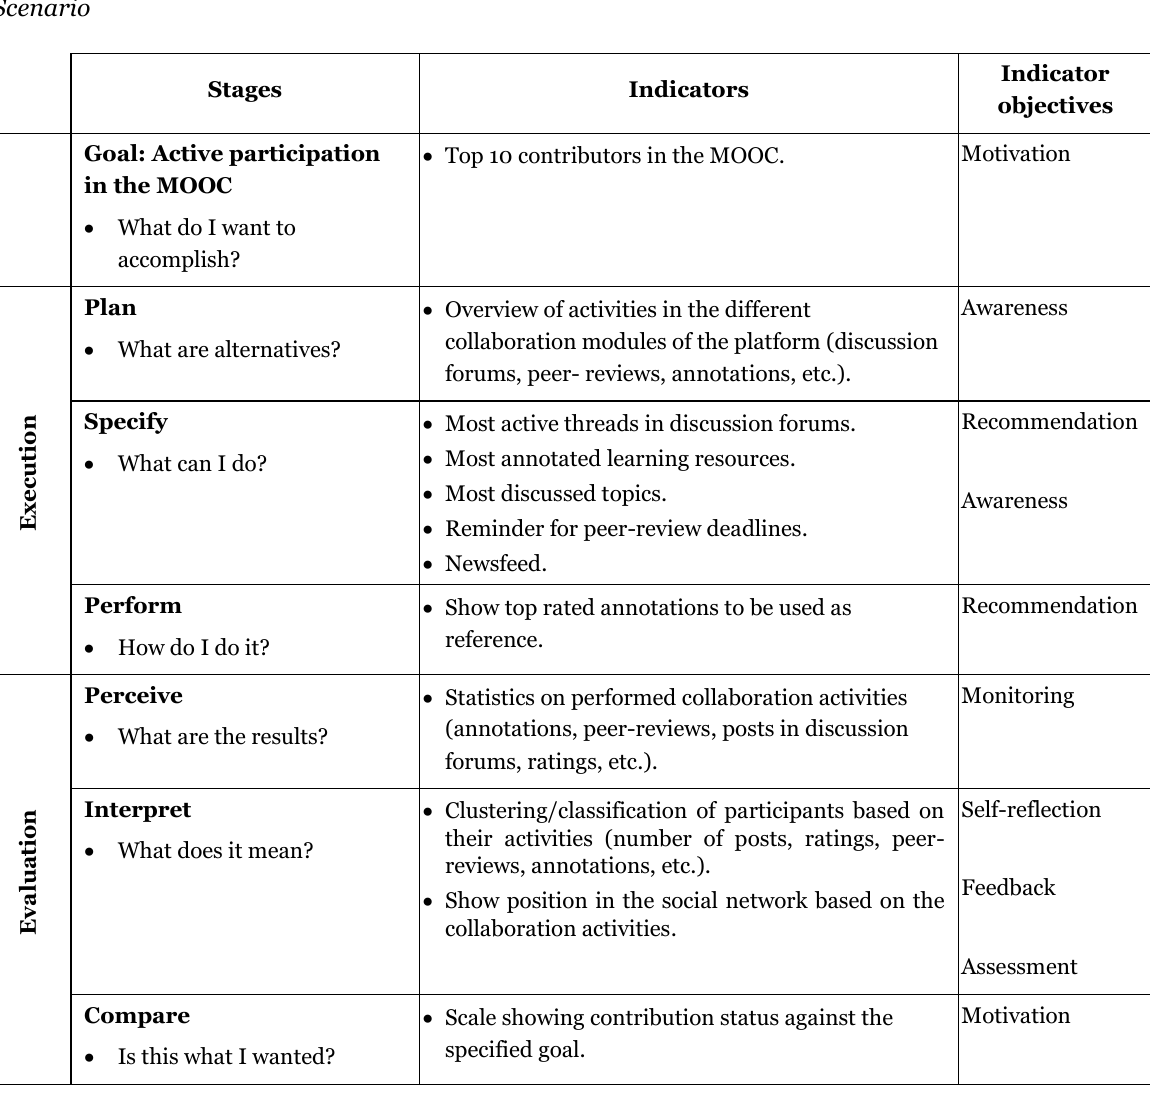
Applying the Seven Stages of the Personalized Learning Activity Cycle to Generate Indicators in a MOOC